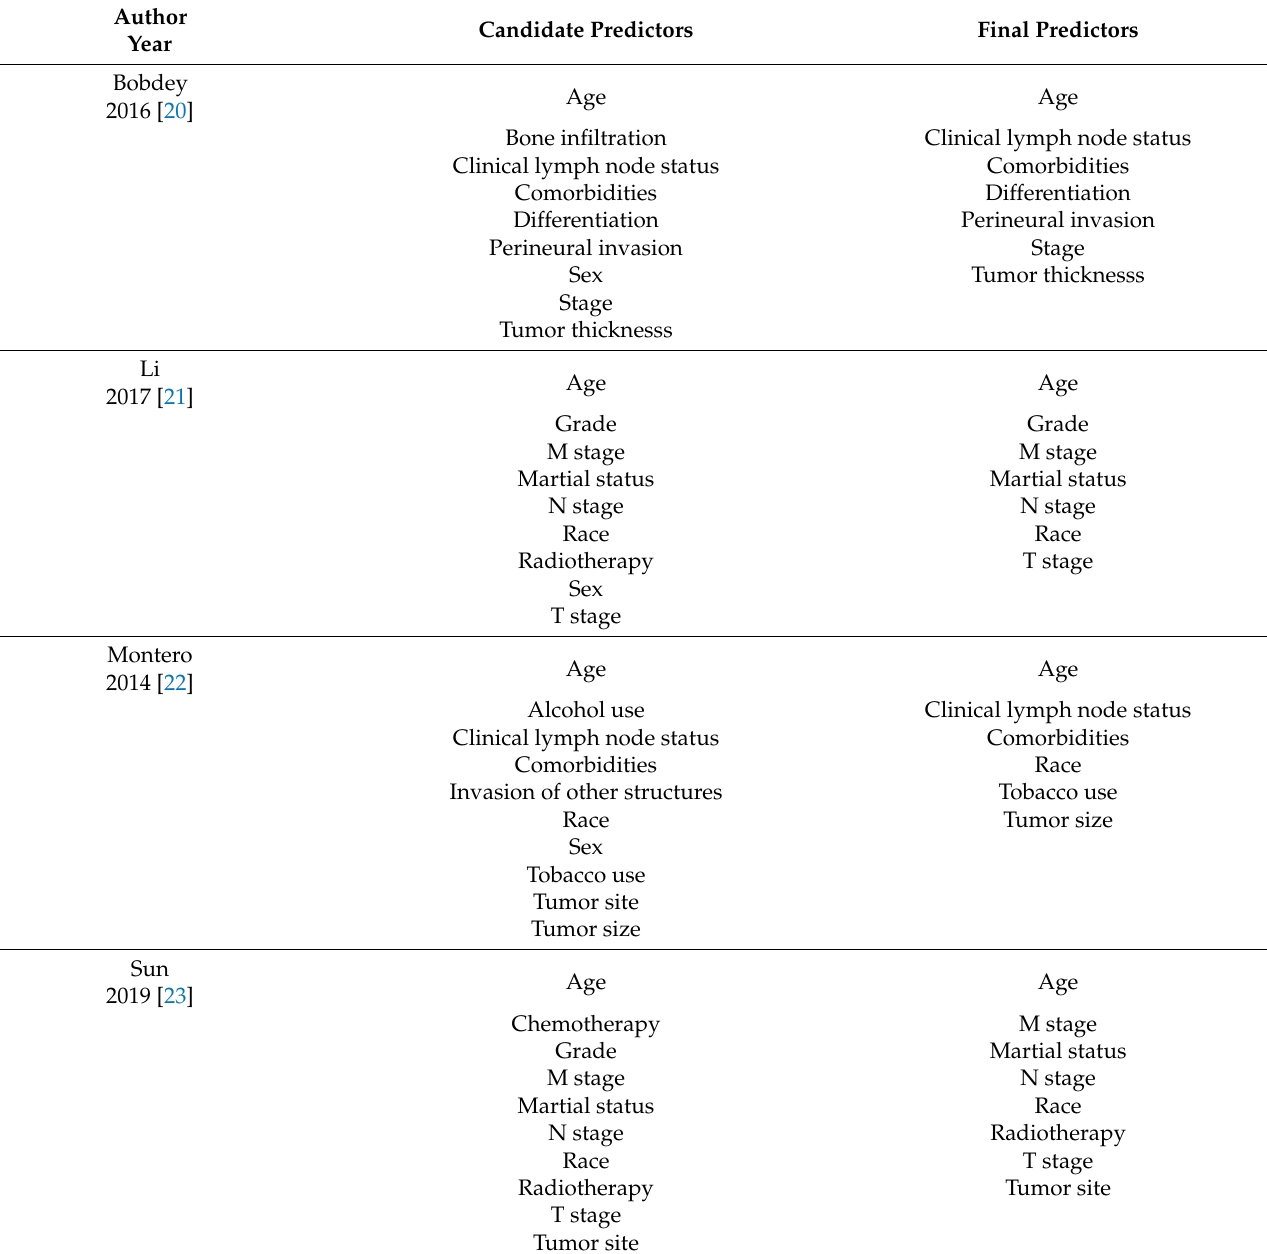
Table 2. Predictors included in the prognostic